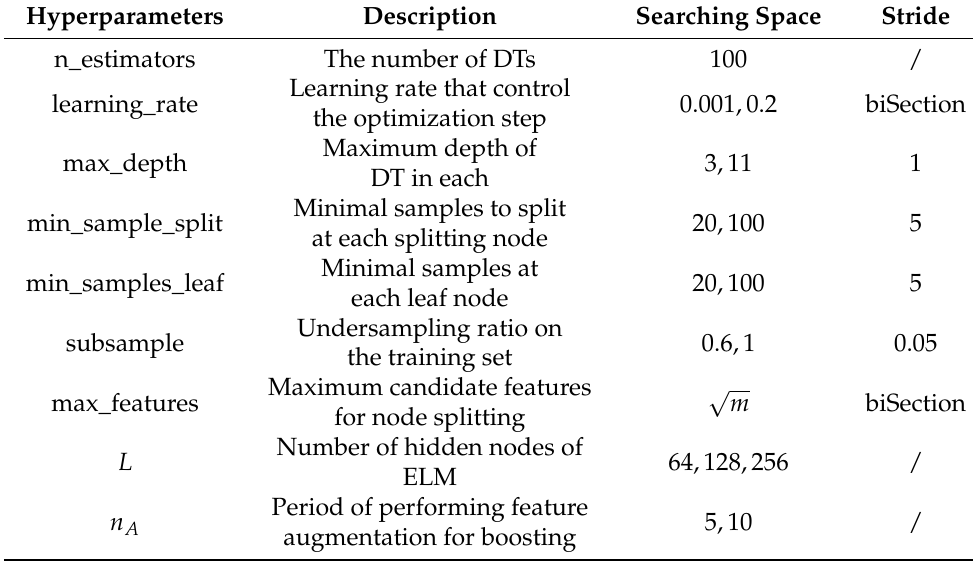
Table 2. Parameters setting of